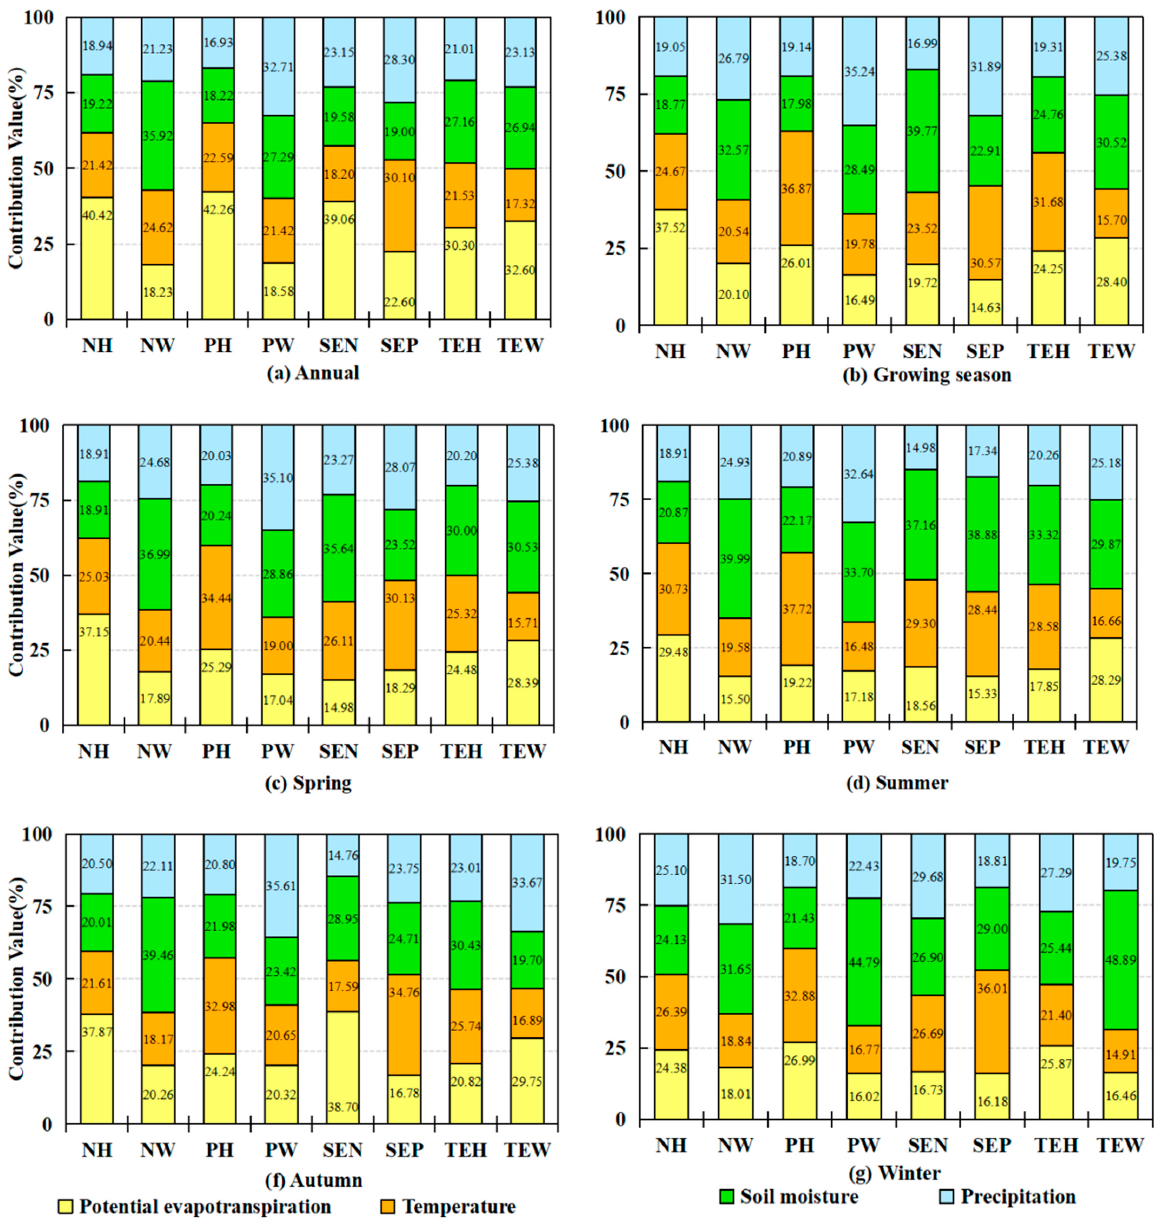
Figure 9. The average contribution value of hydrothermal factors to vegetation growth under dif- ferent function